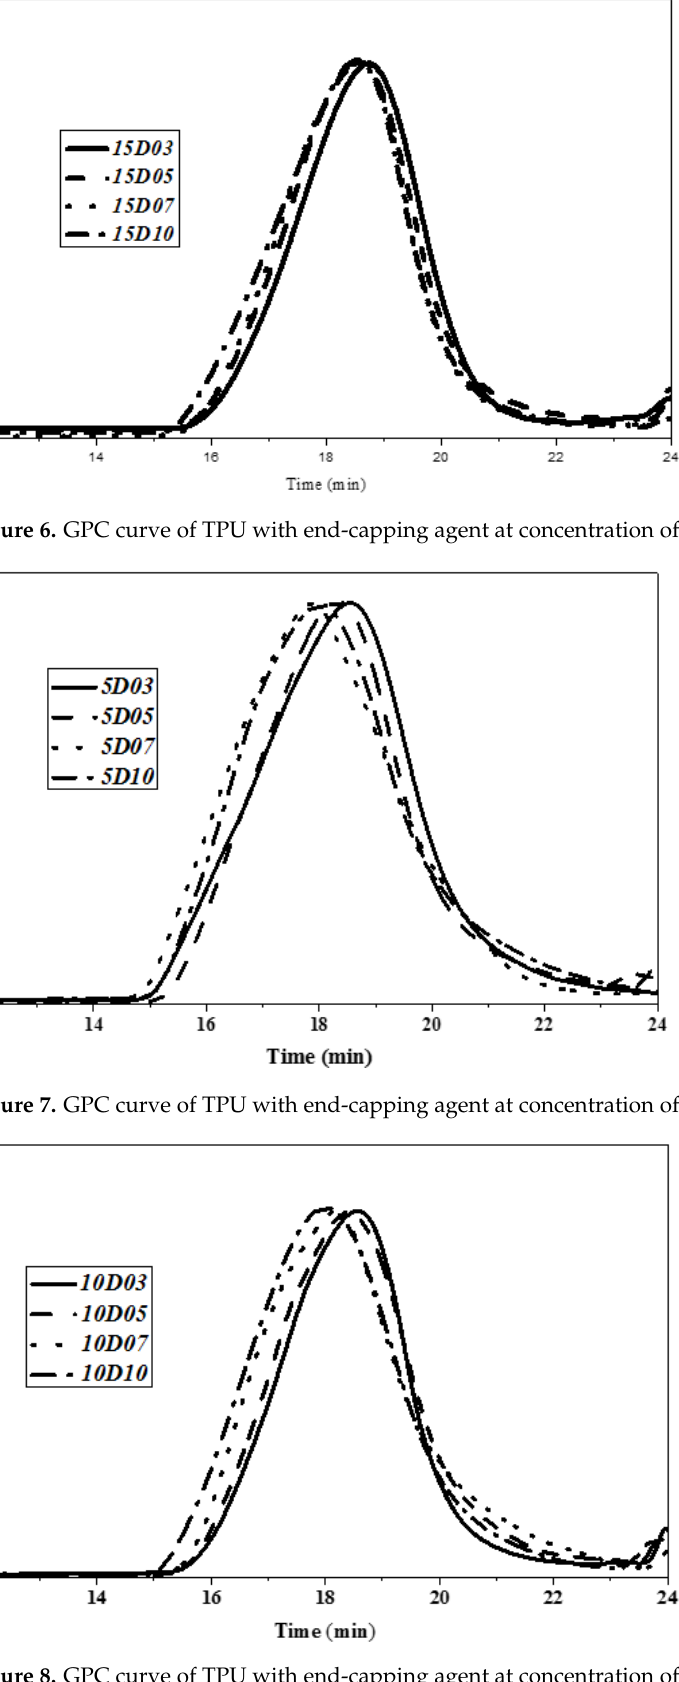
Figure 8. GPC curve of TPU with end-capping agent at concentration of 15 phm.